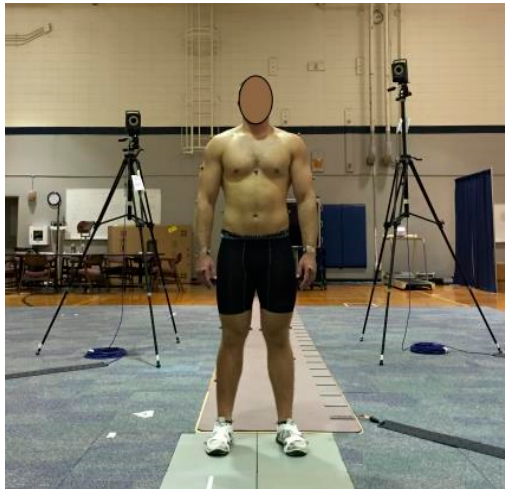
Figure 1. Countermovement jump (CMJ) test environment.